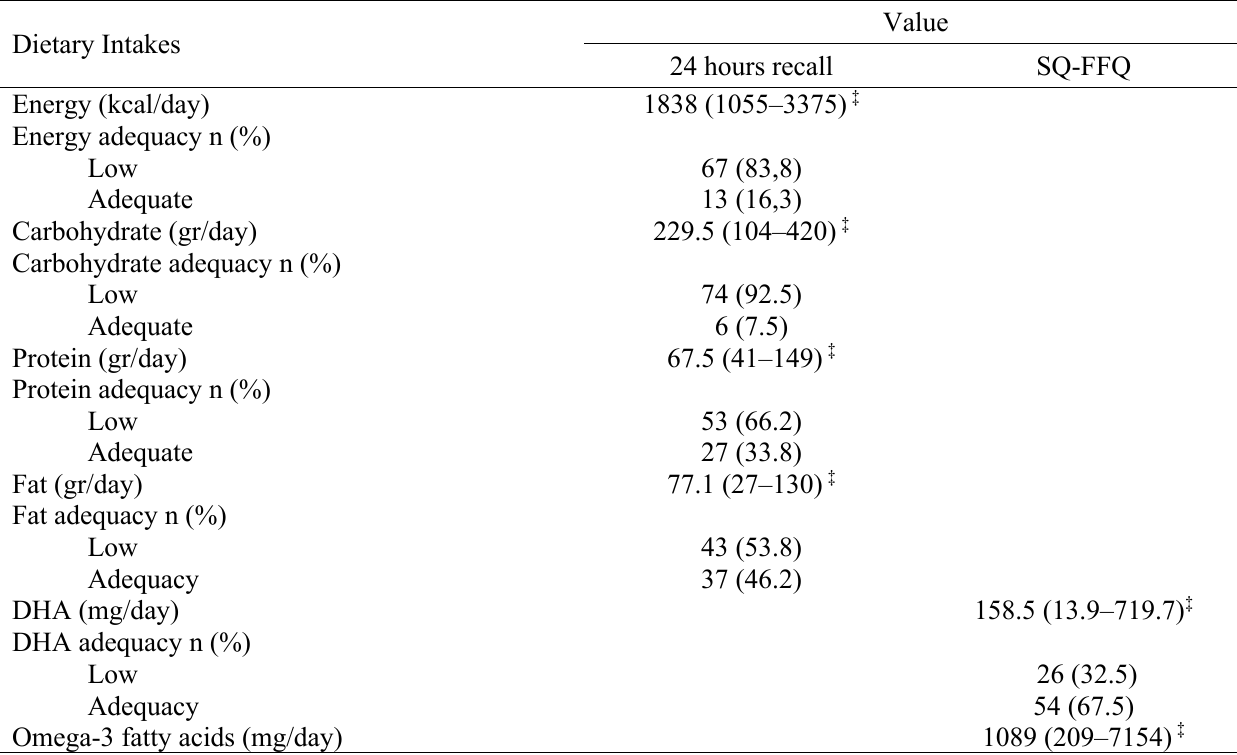
Table 2. Dietary intakes of